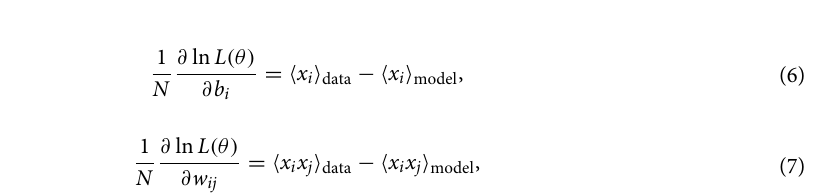
Figure 1. Samples of binarised handwritten digits from MNIST